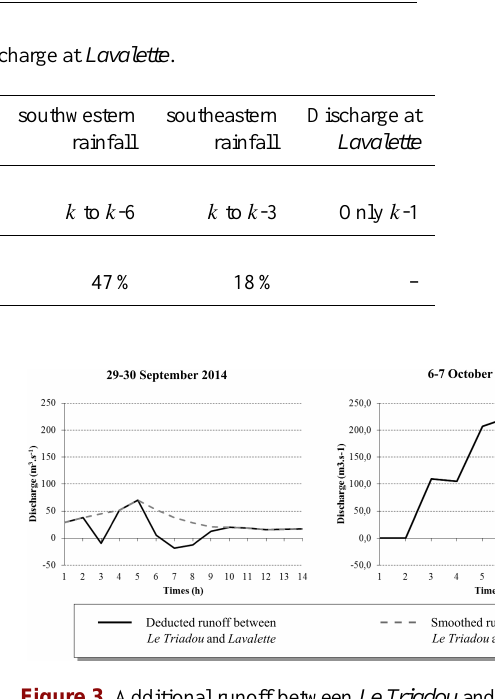
Figure 3. Additional runoff between Le Triadou and Lavalette